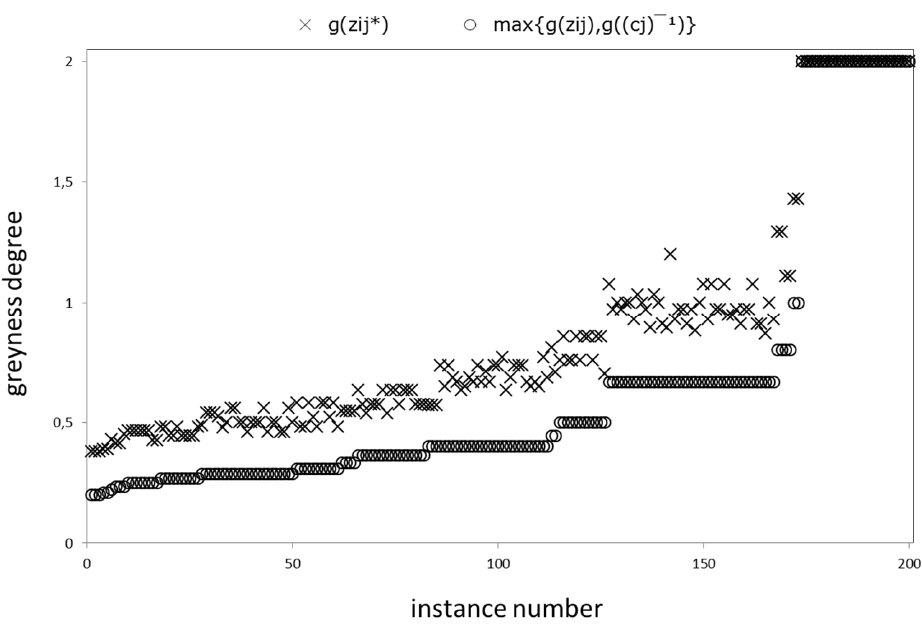
Figure 2. Greyness degree results for normalization.